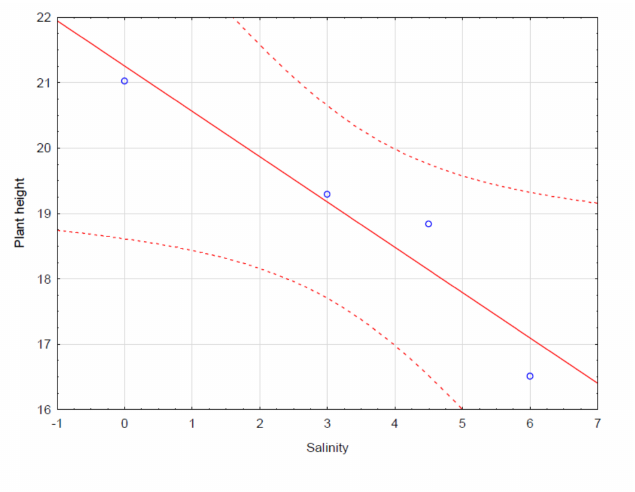
Figure 2. Zinnia correlation between salinity and plant